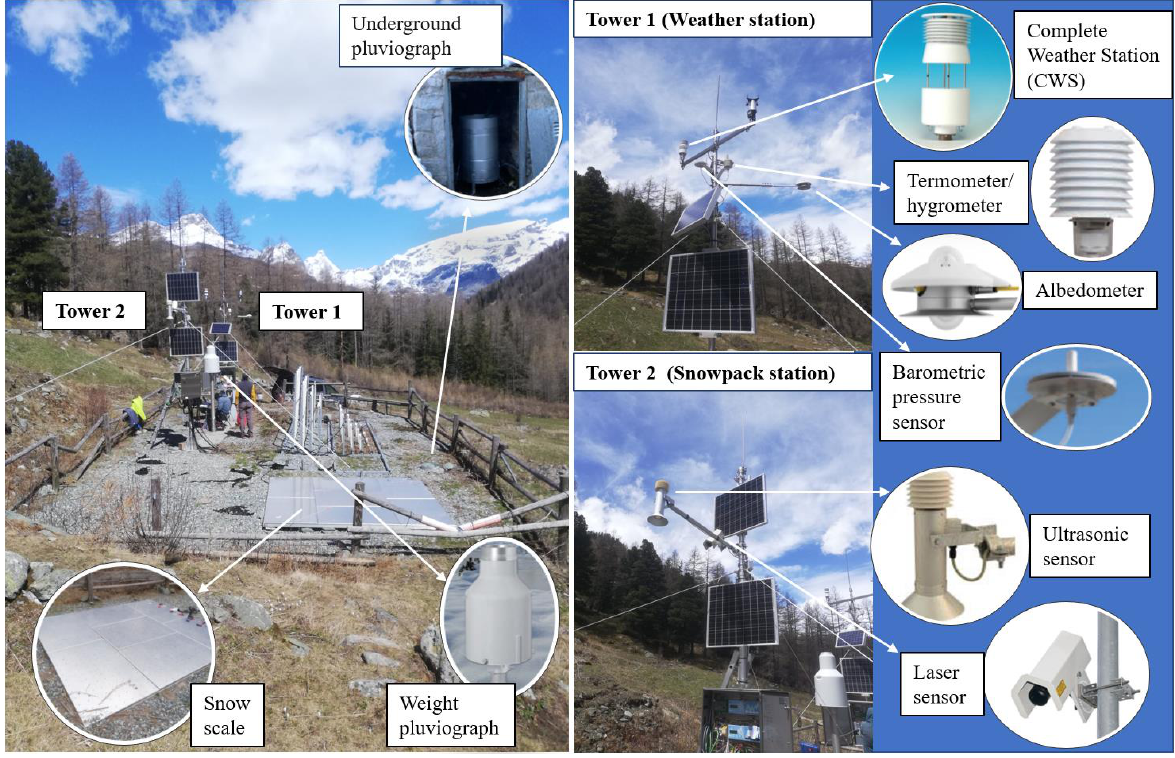
Figure 2. SWS arrangement and equipment .